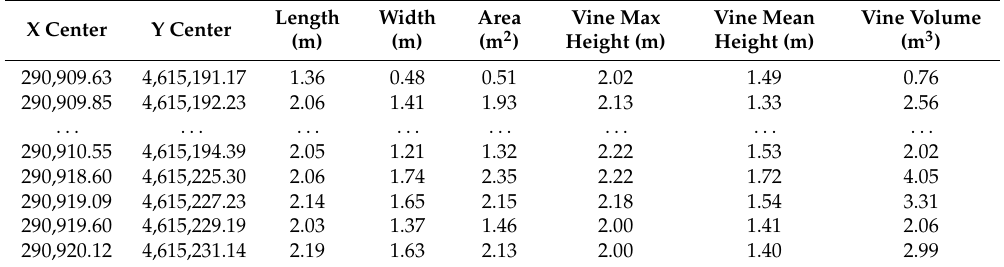
Table 7. A sample of the output data file delivered by the OBIA algorithm for vine of field